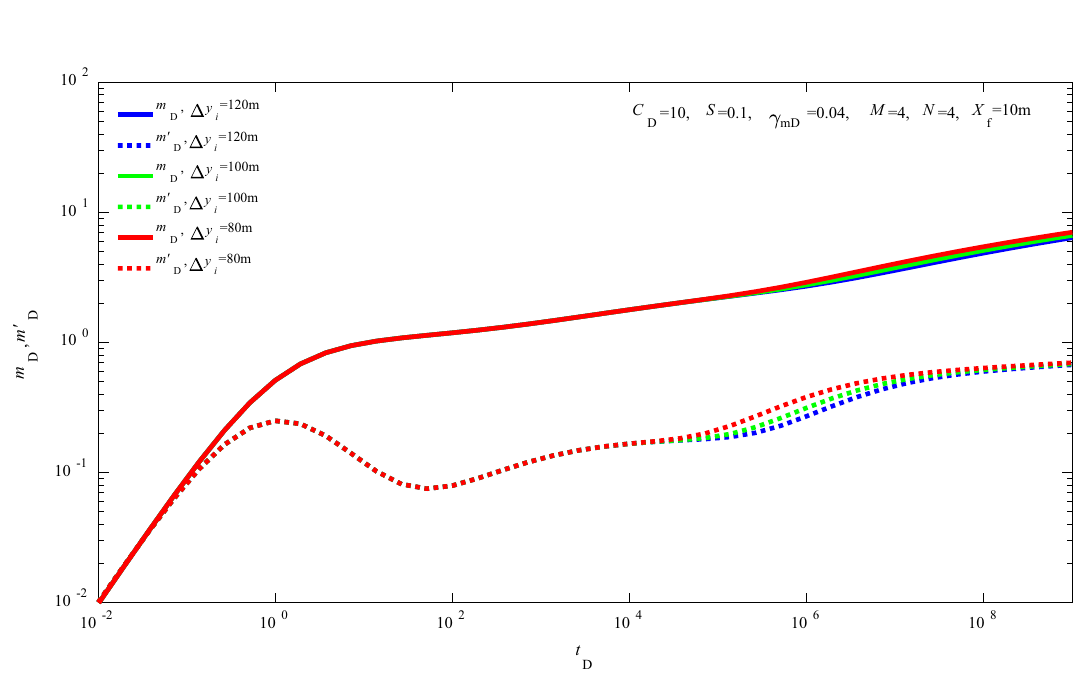
Fig. 6 Effect of fracture spacing on transient pressure